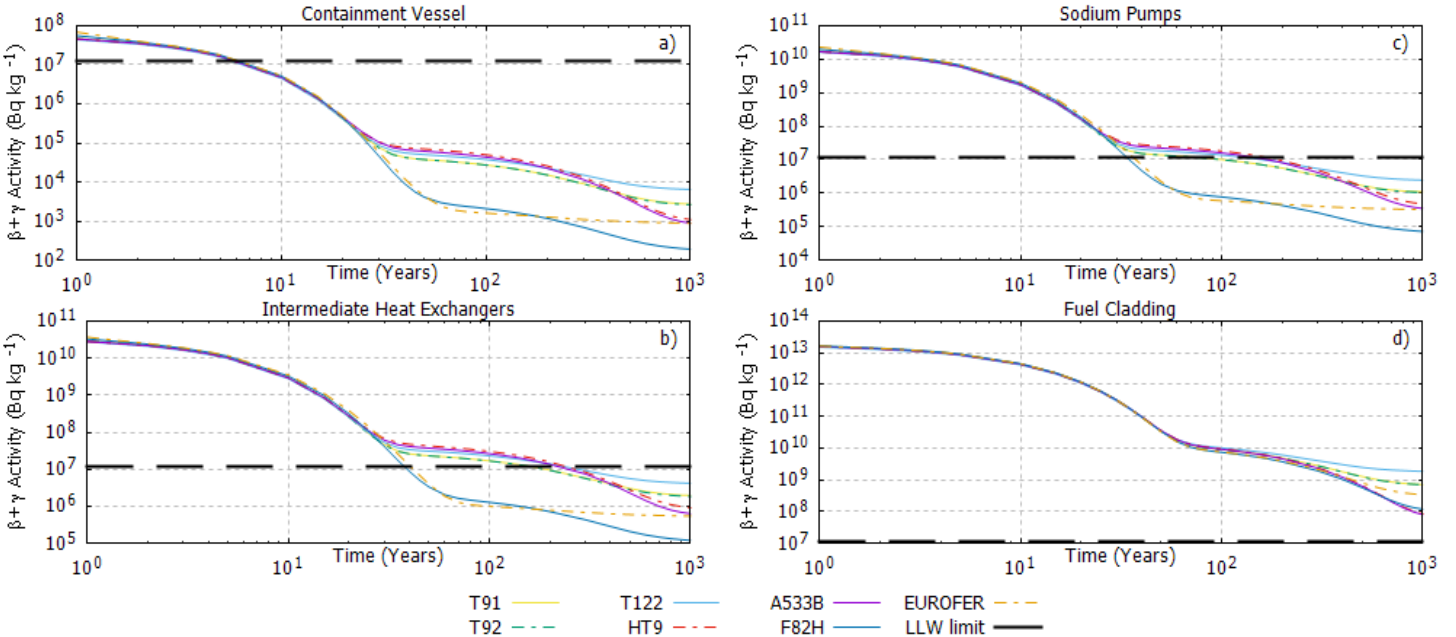
Figure 4. Time Evolution of β+γ Activity (Bq kg -1 ) of Nuclear Industry Steels Used in the (a) Reactor Containment Vessel, (b) Intermediate Heat Exchangers, (c) Sodium Pumps, and (d) Fuel Cladding of the European Sodium-cooled Fast Reactor. LLW β+γ Activity Limit Denoted with Black Dashed